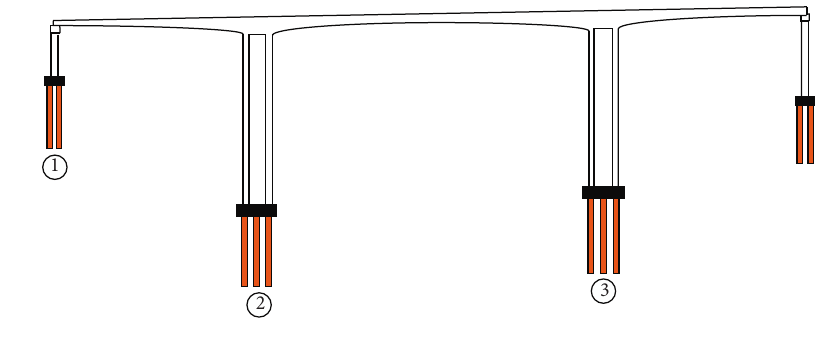
Figure 3: Bridge layout diagram.